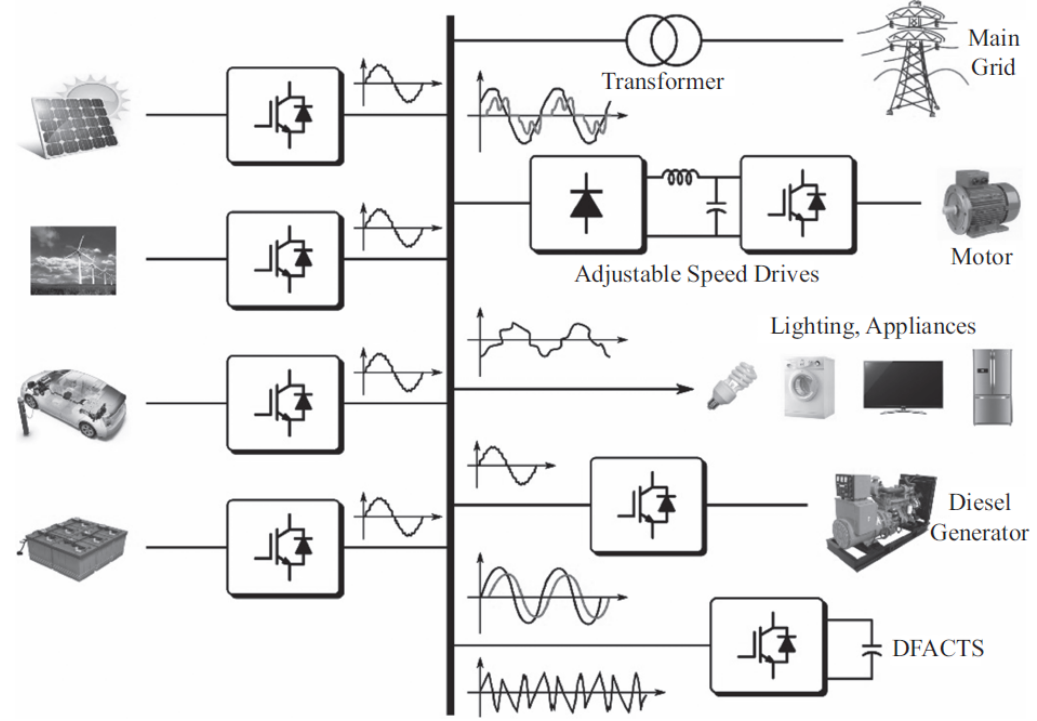
Figure 2. A general system structure for microgrid.